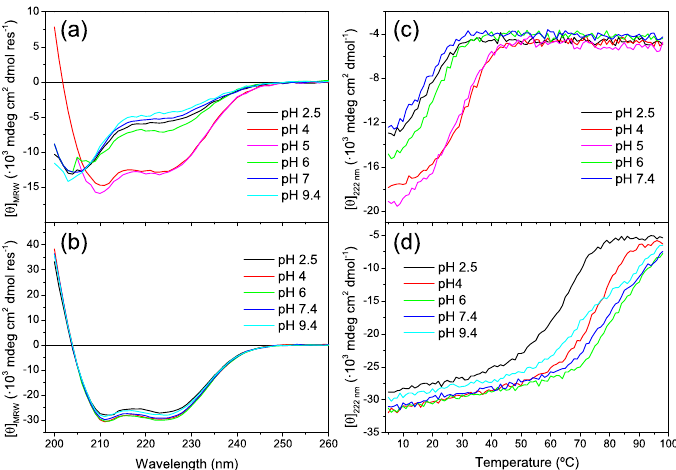
Figure 7. Secondary structure and stability of shortened CoVS-HR1 miniproteins. ( a , b ) Far-UV CD spectra of the CoVS-HR1-N ( a ) and CoVS-HR1-C ( b ) miniproteins measured at 25 °C at varying pH values. ( c , d ) Thermal scans monitored by CD at 222 nm at varying pH for the N ( c ) and C ( d ) miniproteins. Experiments were carried out with 15 μ M samples.